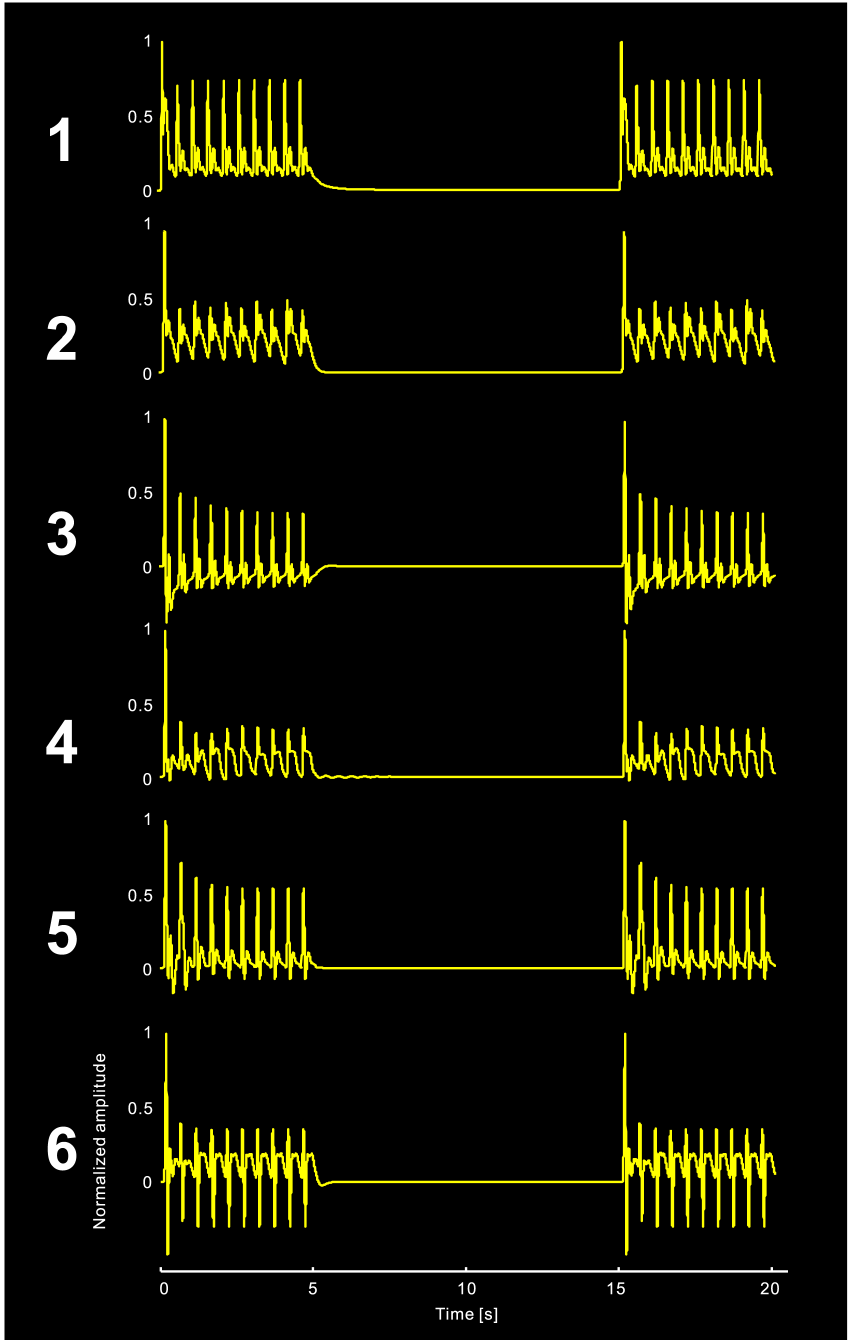
Figure 7. Simulated data to demonstrate that the N100m peak recovers completely during the 10 s stimulus free time.